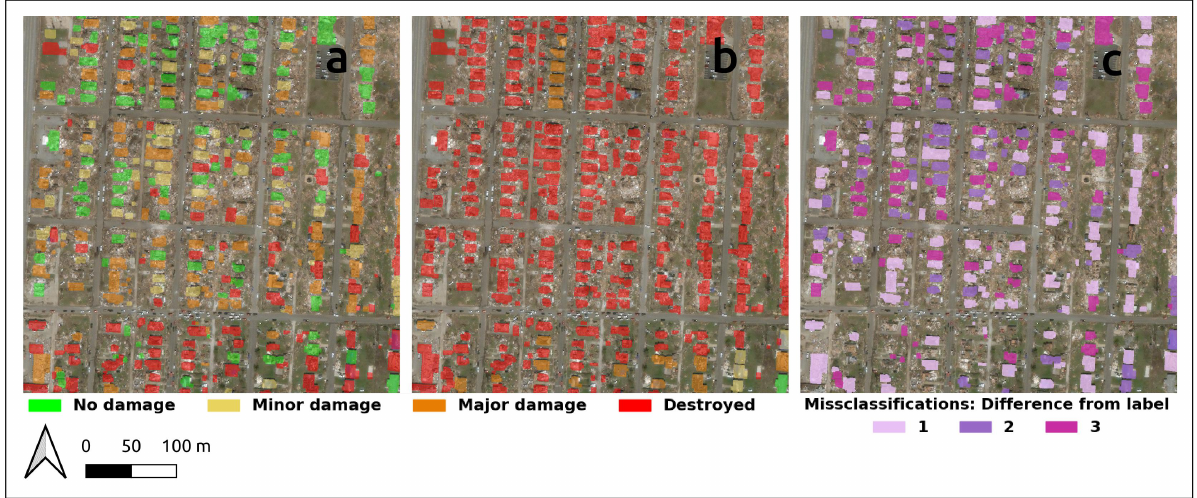
Figure 7. Application of ProtoNet model on a test case from tornado Joplin. Satellite image overlaid with: ( a ) the predictions, ( b ) the labels and ( c ) the difference between the two.